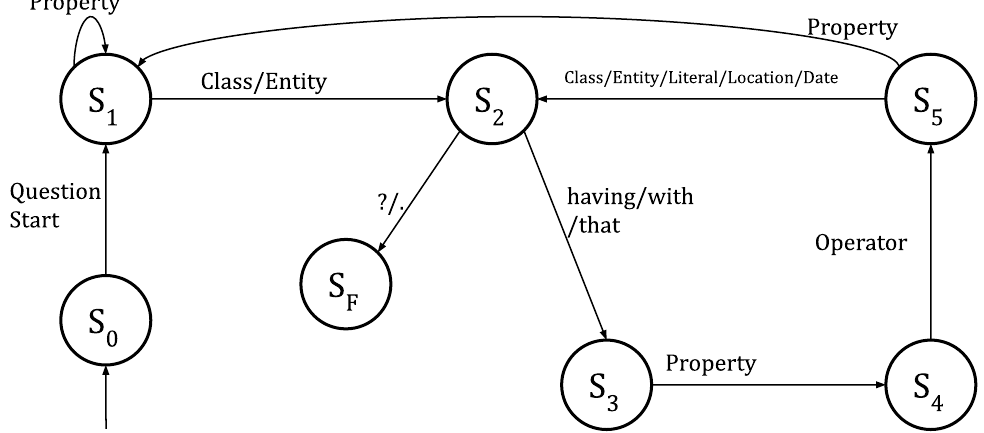
Figure 2. Structure of the FSA used to translate the natural language